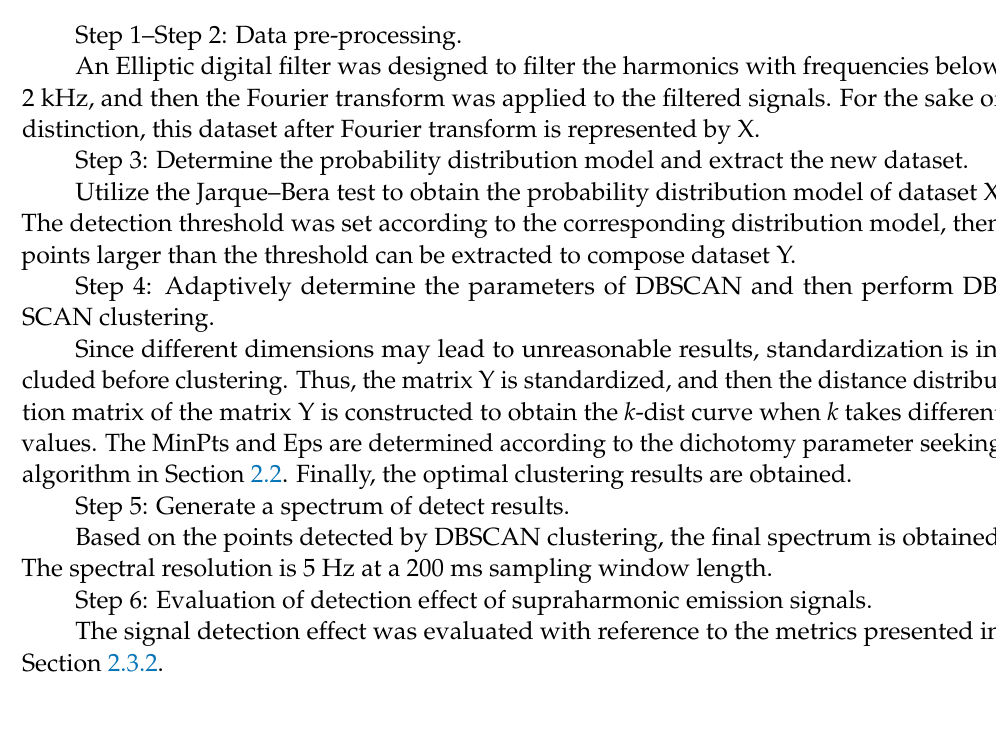
Figure 2. The flow chart of the proposed SD-DBSCAN